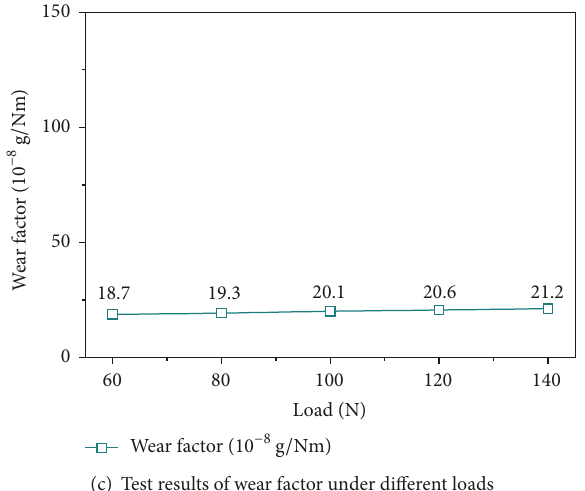
Figure 5: Test results of wear factor under different temperatures, rotation speeds, and